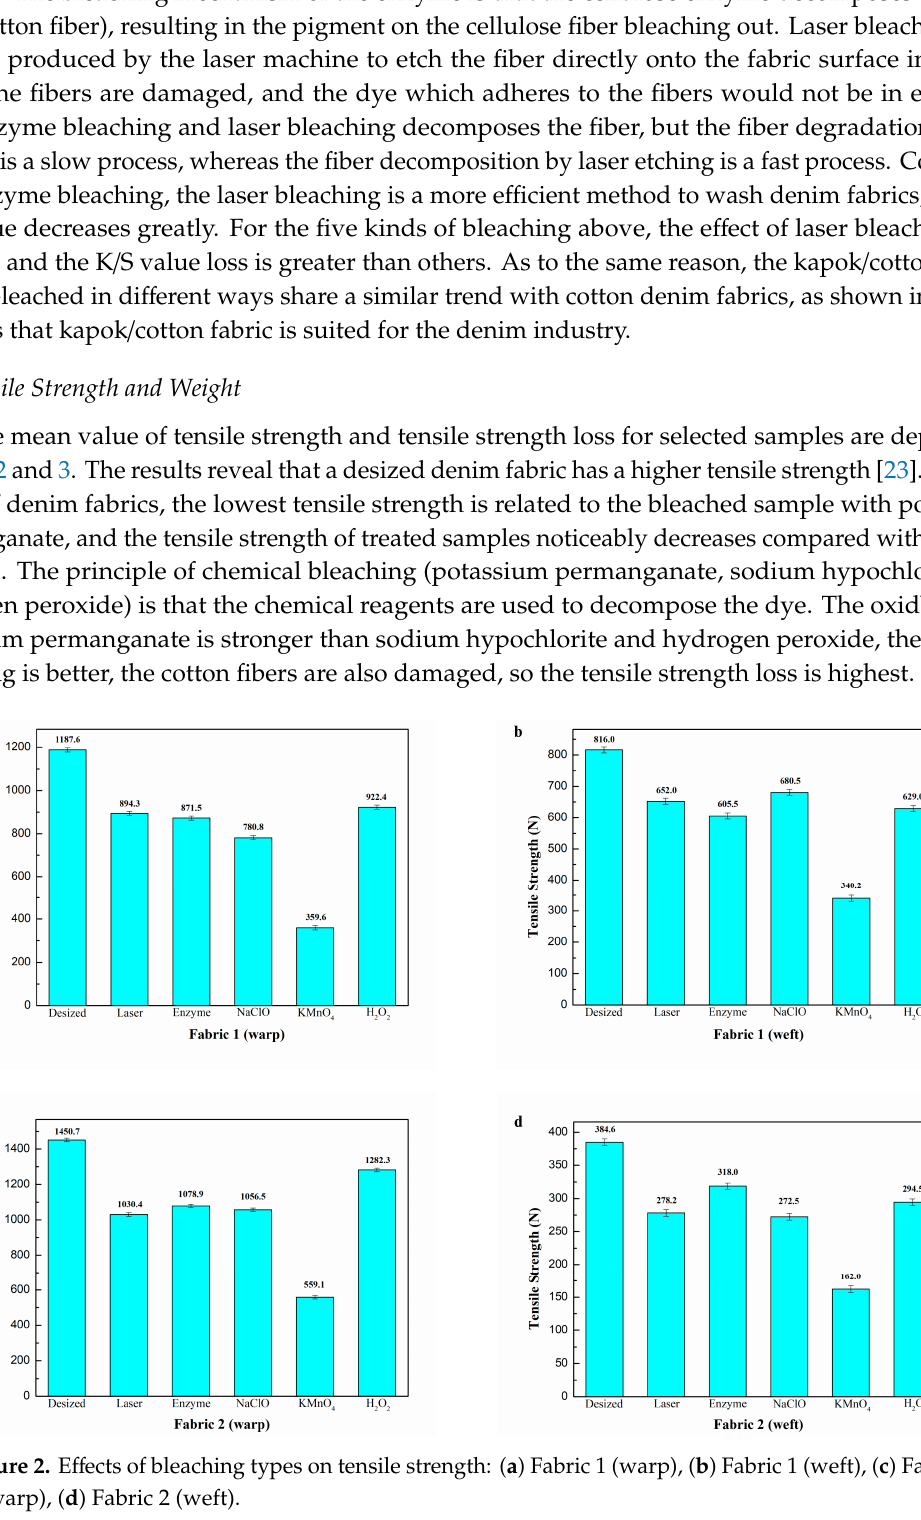
Figure 2. E ff ects of bleaching types on tensile strength: ( a ) Fabric 1 (warp), ( b ) Fabric 1 (weft), ( c ) Fabric 2 (warp), ( d ) Fabric 2 (weft).